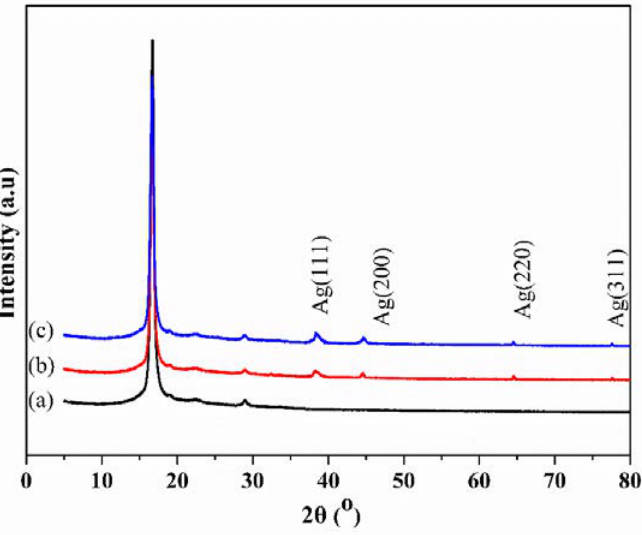
5 of 13 Figure 1. FTIR spectra of ( a ) chitosan; ( b ) control PLA nonwoven fabrics; ( c ) DBD-CS-Ag NPs treated fabric. 3.2. XRD Analysis In order to verify the chemical state of Ag NPs on the surface of PLA nonwoven fab-